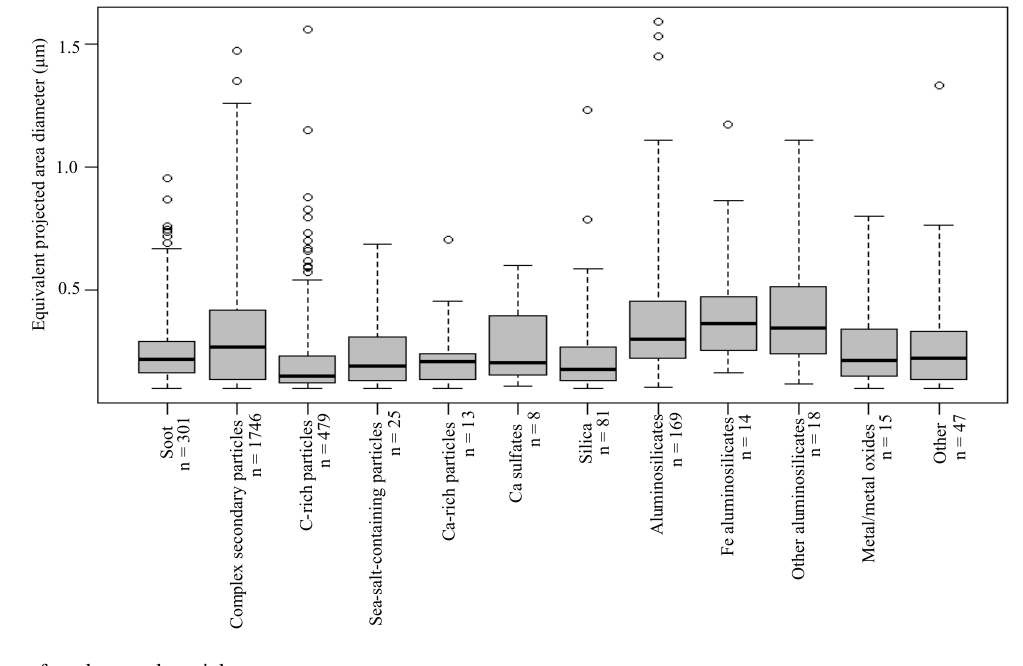
Figure 5. Size of total aerosol